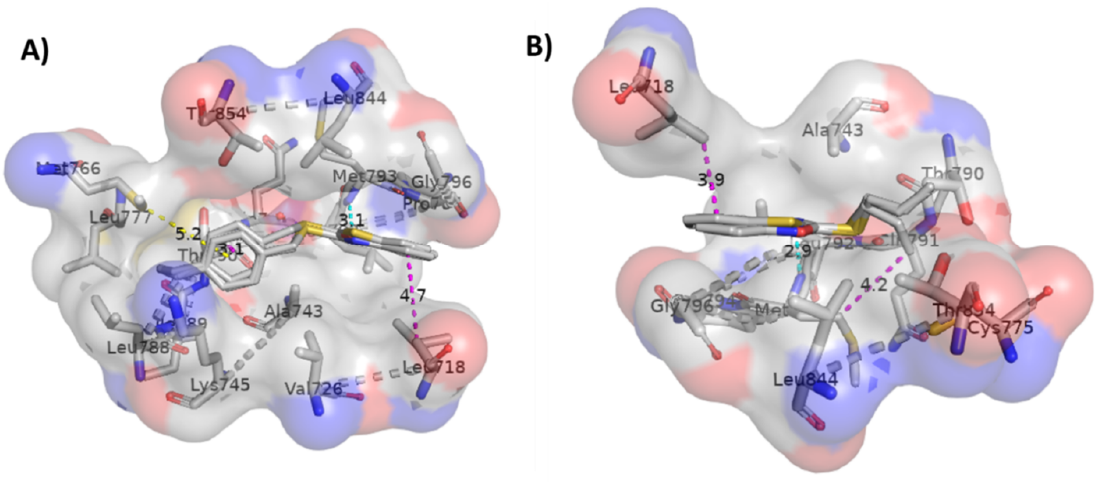
Figure 1. Interaction maps between receptor EGFR and molecules ( A ) BTA-1 , BZM-2 , and BOX-3 ( B ) BTA-4 , BZM-5 , and BOX-6 . Cyan dashed lines are hydrogen bonds, magenta are pi–alkyl interactions, and yellow are pi–sulfur interactions.